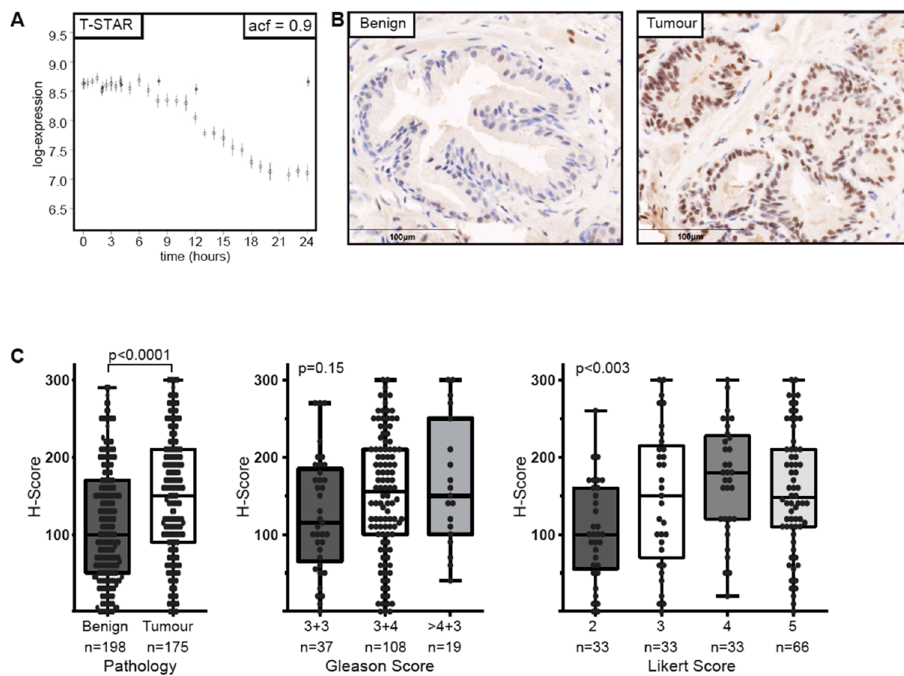
Figure 2. T-STAR is overexpressed in prostate cancer. ( A ) Androgen regulation of T-STAR determined by expression analysis of LNCaP cell lines treated with synthetic androgen (open circles) or vehicle control (filled circles) over 24hrs. ACF = autocorrelation function. ( B ) Examples of immunohistochemistry (IHC) of T-STAR showing benign (left) and tumour (right) tissue. Staining is shown in brown with nuclei shown in blue. ( C ) Staining was analysed by h-score and analysed based on pathology (left), Gleason score (centre) and Likert score (right). Dots represent individual patients, whiskers extend to the minimum and maximum data points, the boxes represent data from first to third quartile, and the horizontal line represents the mean. Significance was analysed using two-tailed Mann–Whitney test.